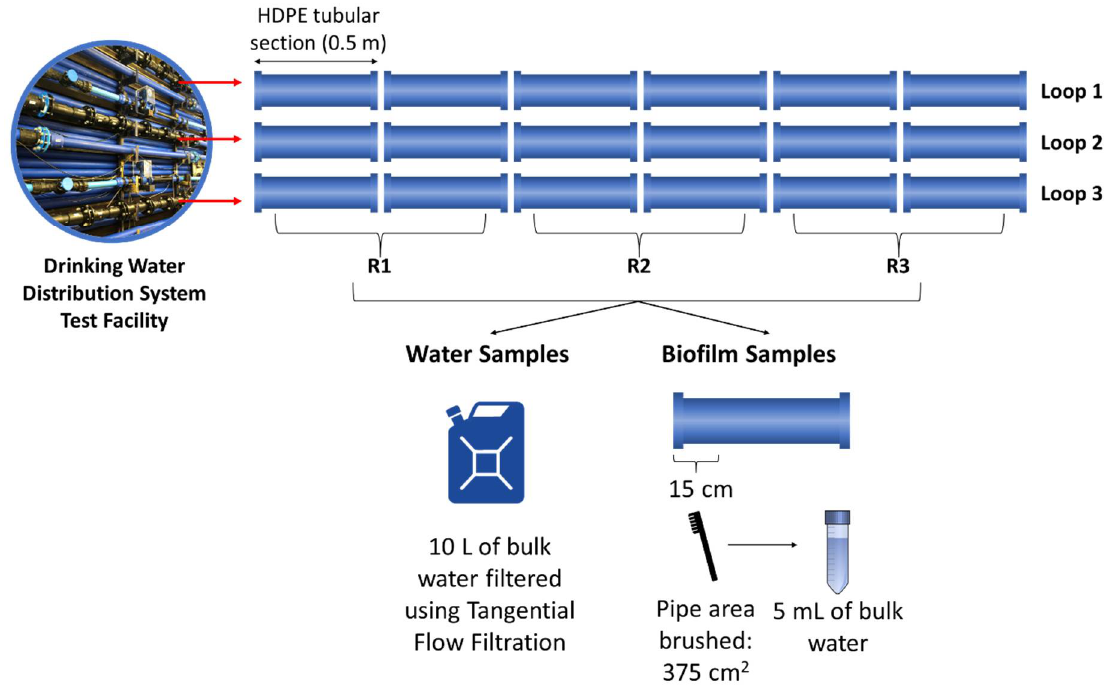
Figure 2. Schematic representation of planktonic and biofilm microbial communities sampling.